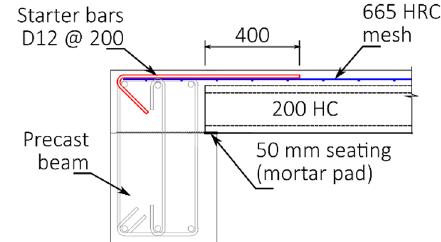
Fig. 7 Connection detailing of the sub-system test by Bueker et al. (2020)